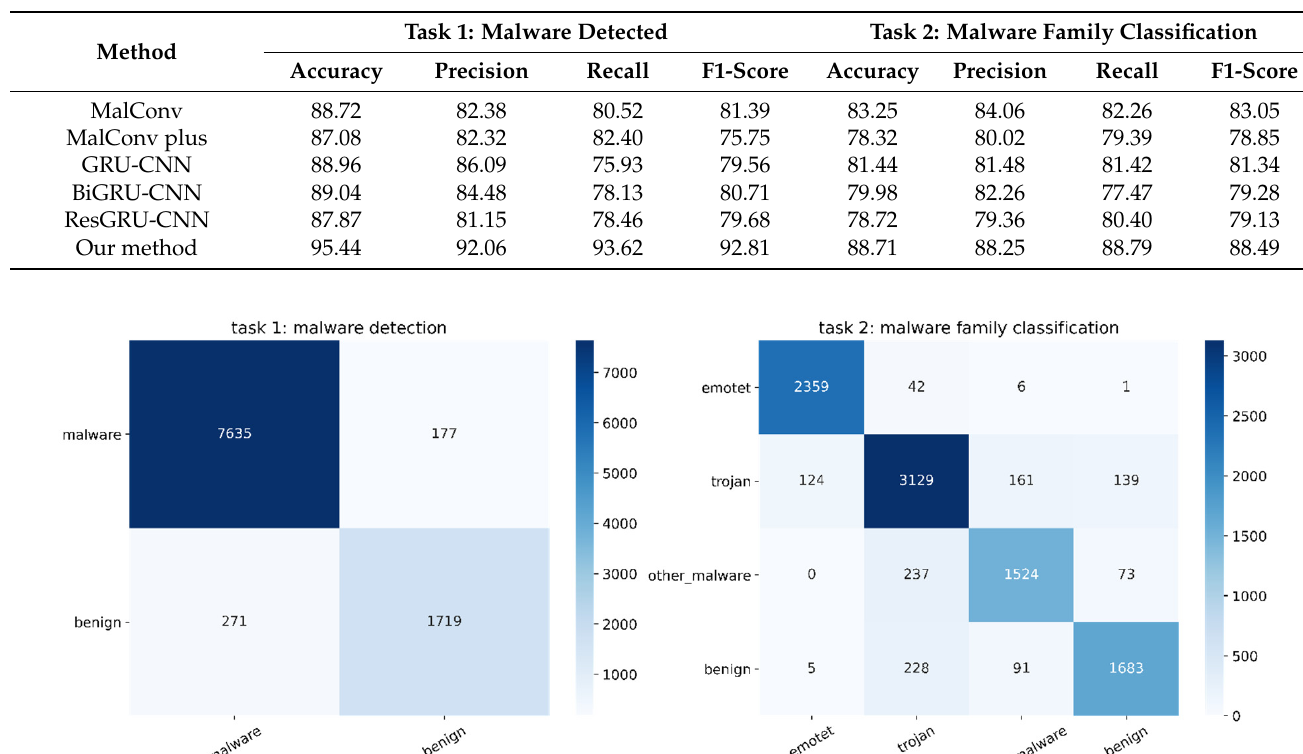
Table 7. Comparisons with the baseline models on the test set of Dataset B.